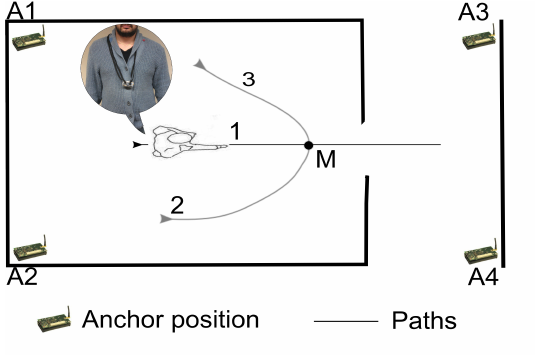
Figure 6. Experimental setting: generic representation of the anchors’ position and prototypical user trajectories. Straight path, labeled as 1, yields to a room exit, while curved movement (paths 2 and 3) preserves the spatial context. The M markers denote the points where the system predicts whether the user is going to exit the room. The actual setting differs from this schematics by the presence of office furniture (covering roughly 50% of the space) that is asymmetrically arranged and influences the actual user trajectories in the different